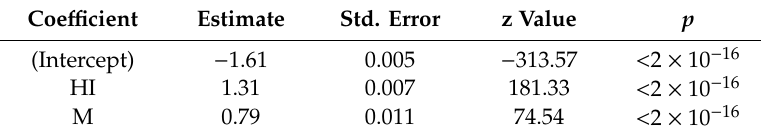
Table 6. Model coe ffi cients for the model based on the full dataset (33